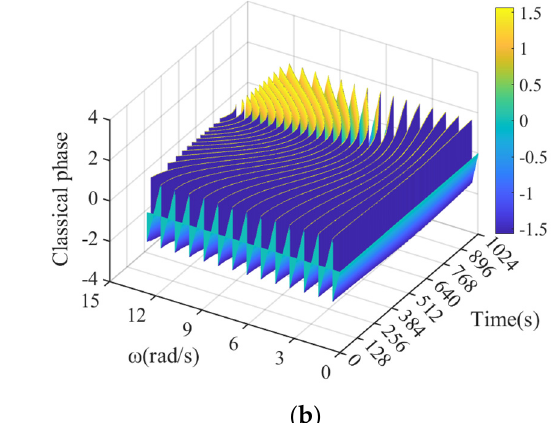
( , ) R t τ ; ( b ) ( , ) R t τ . ( t , τ ) ; ( b ) R ( t , τ ) . 21,21 1,21 21,21 1,21